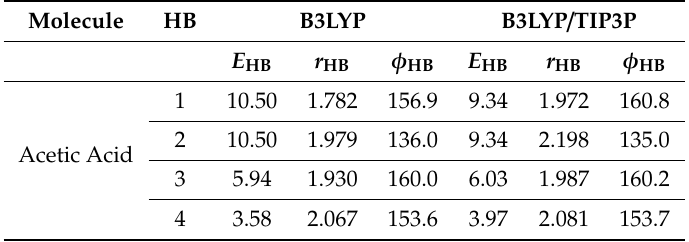
Table A2. Comparison of the hydrogen bond binding energy ( E HB in kcal / mol), distance ( r HB in Å) and angle ( φ HB in degrees) as calculated with B3LYP and B3LYP / TIP3P. For the structure and nomenclature of the hydrogen bond evaluated for di ff erent organic molecules / water and amino acids / water pairs refer to Figure A1 in Appendix